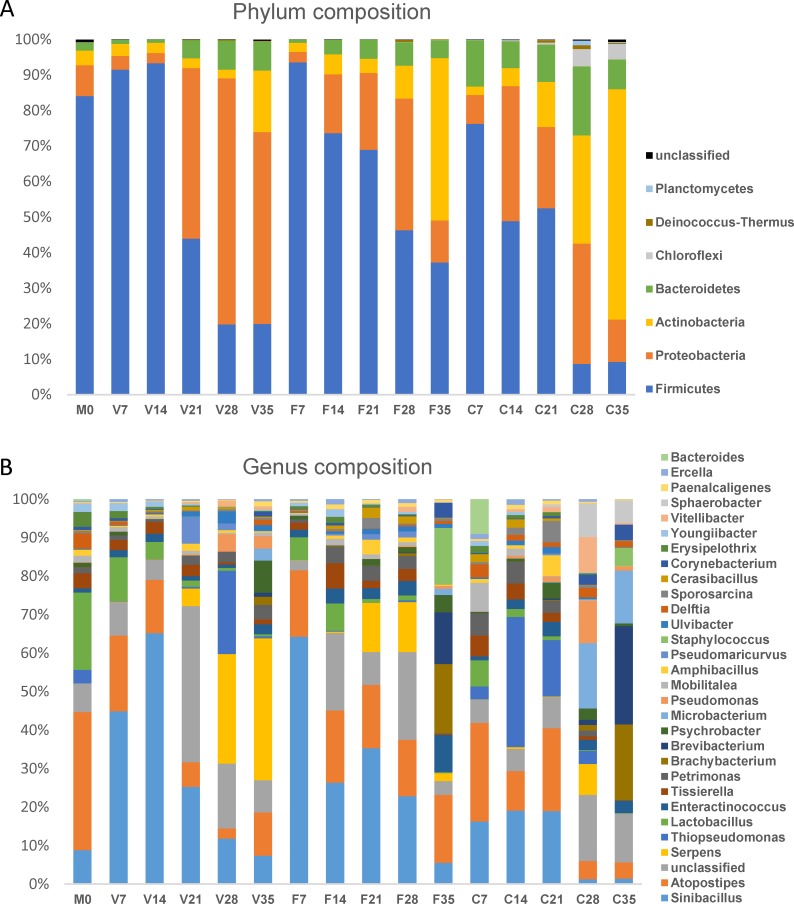
The dynamics of compost bacterial phylum and genus composition of V, F and C composts.M0, D0 poultry manure; 0, 7, 14, 21, 28, 35, sampling time points. The species legend from bottom to top was illustrated according to the corresponding colors in each column.